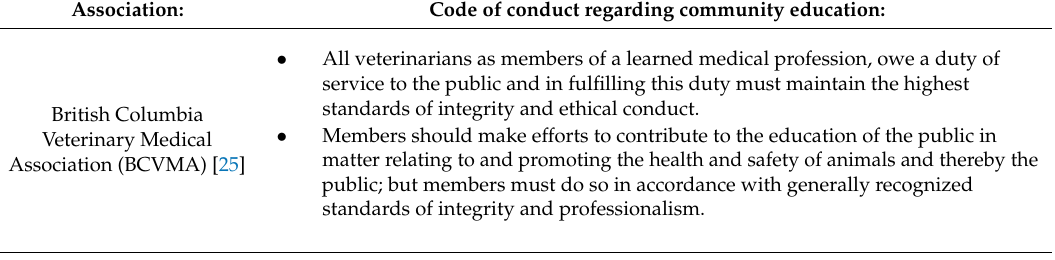
Table 1. Professional responsibilities of veterinarians across